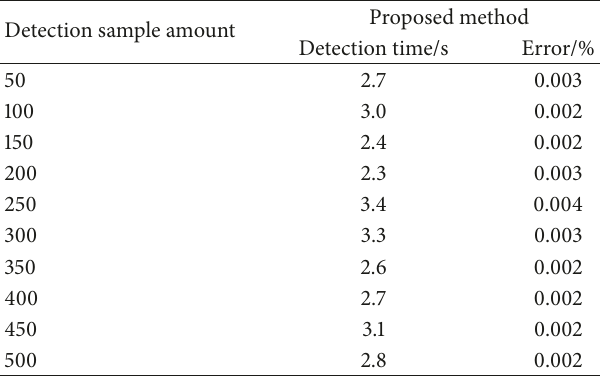
Table6:Numberofiterationsandfitnessofoutlierdatafeature-state responses detected with the proposed